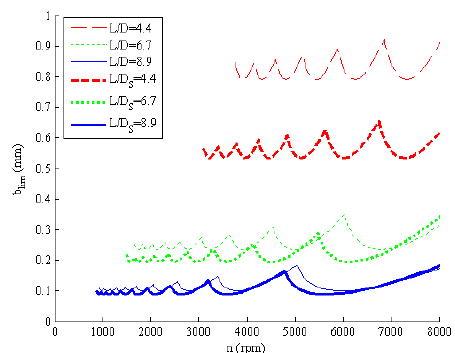
Figure 10. Chatter stability lobes for different L/D ratios.